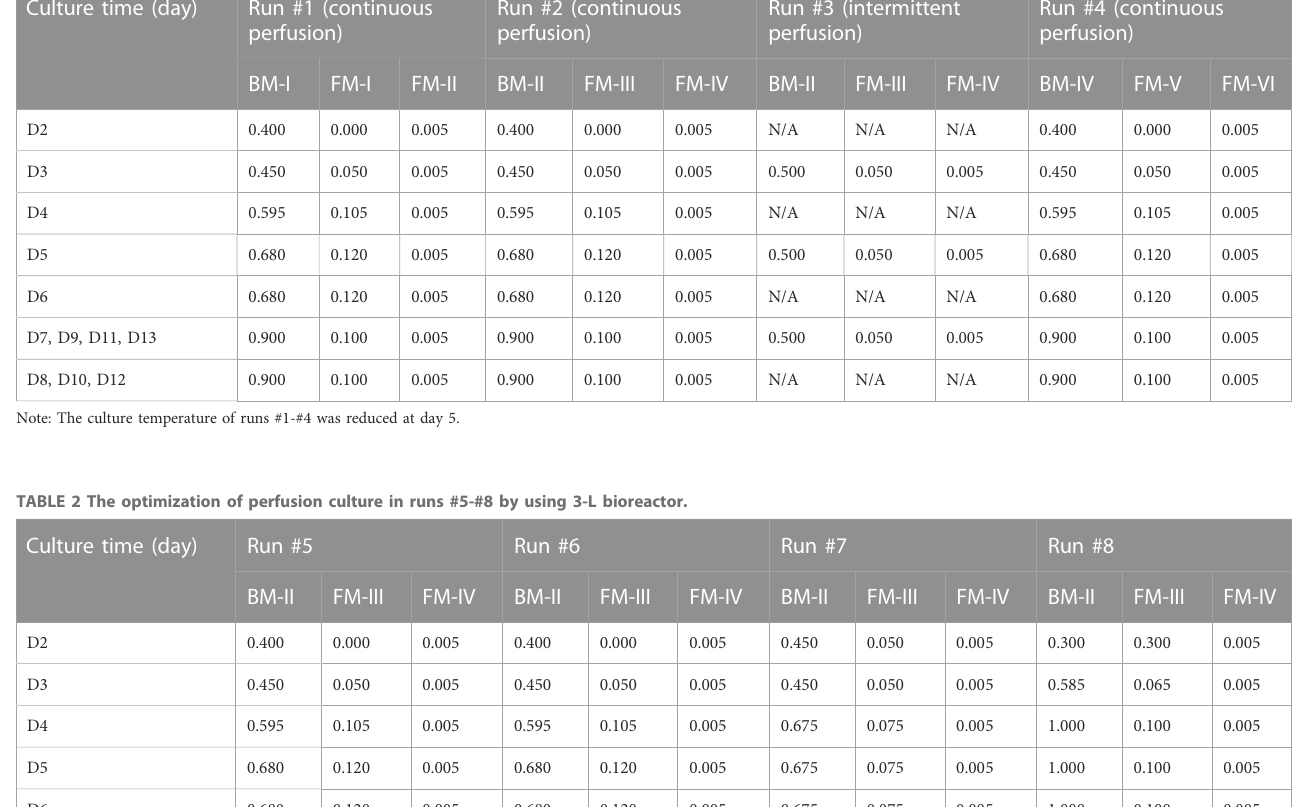
TABLE 1 The perfusion rates (VVD) of perfusion media in runs #1-#4 by using 3-L bioreactor. Culture time (day)